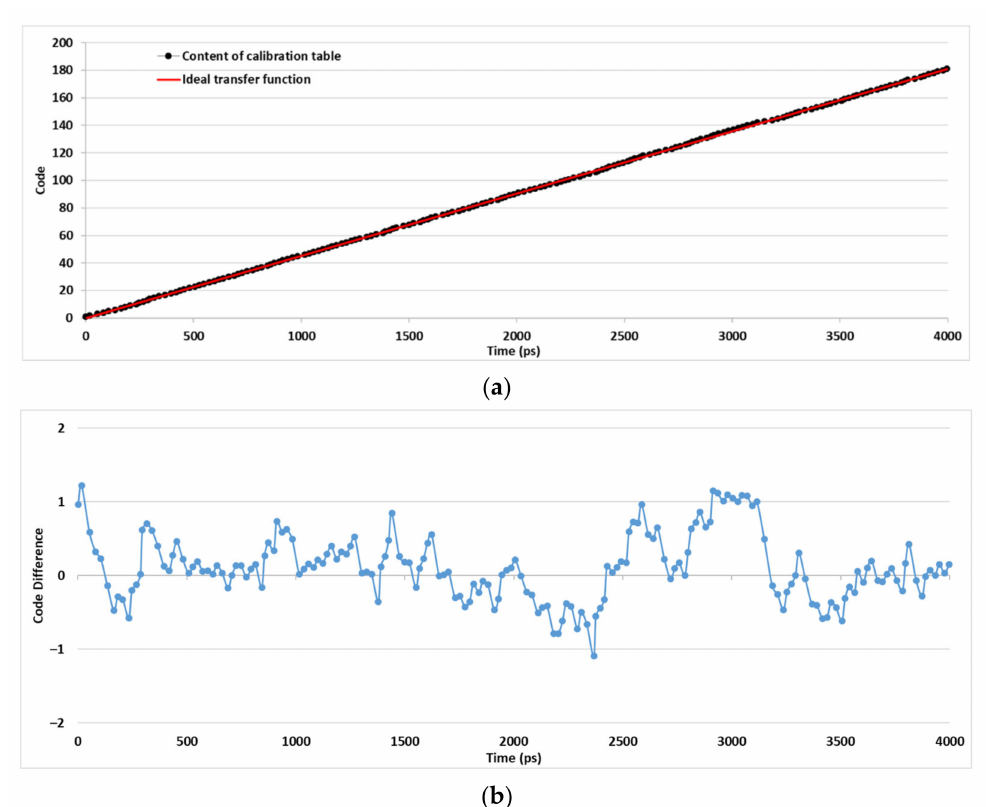
Figure 9. ( a ) Comparison of the TDC calibration table content and the ideal transfer function. ( b ) The differences between the